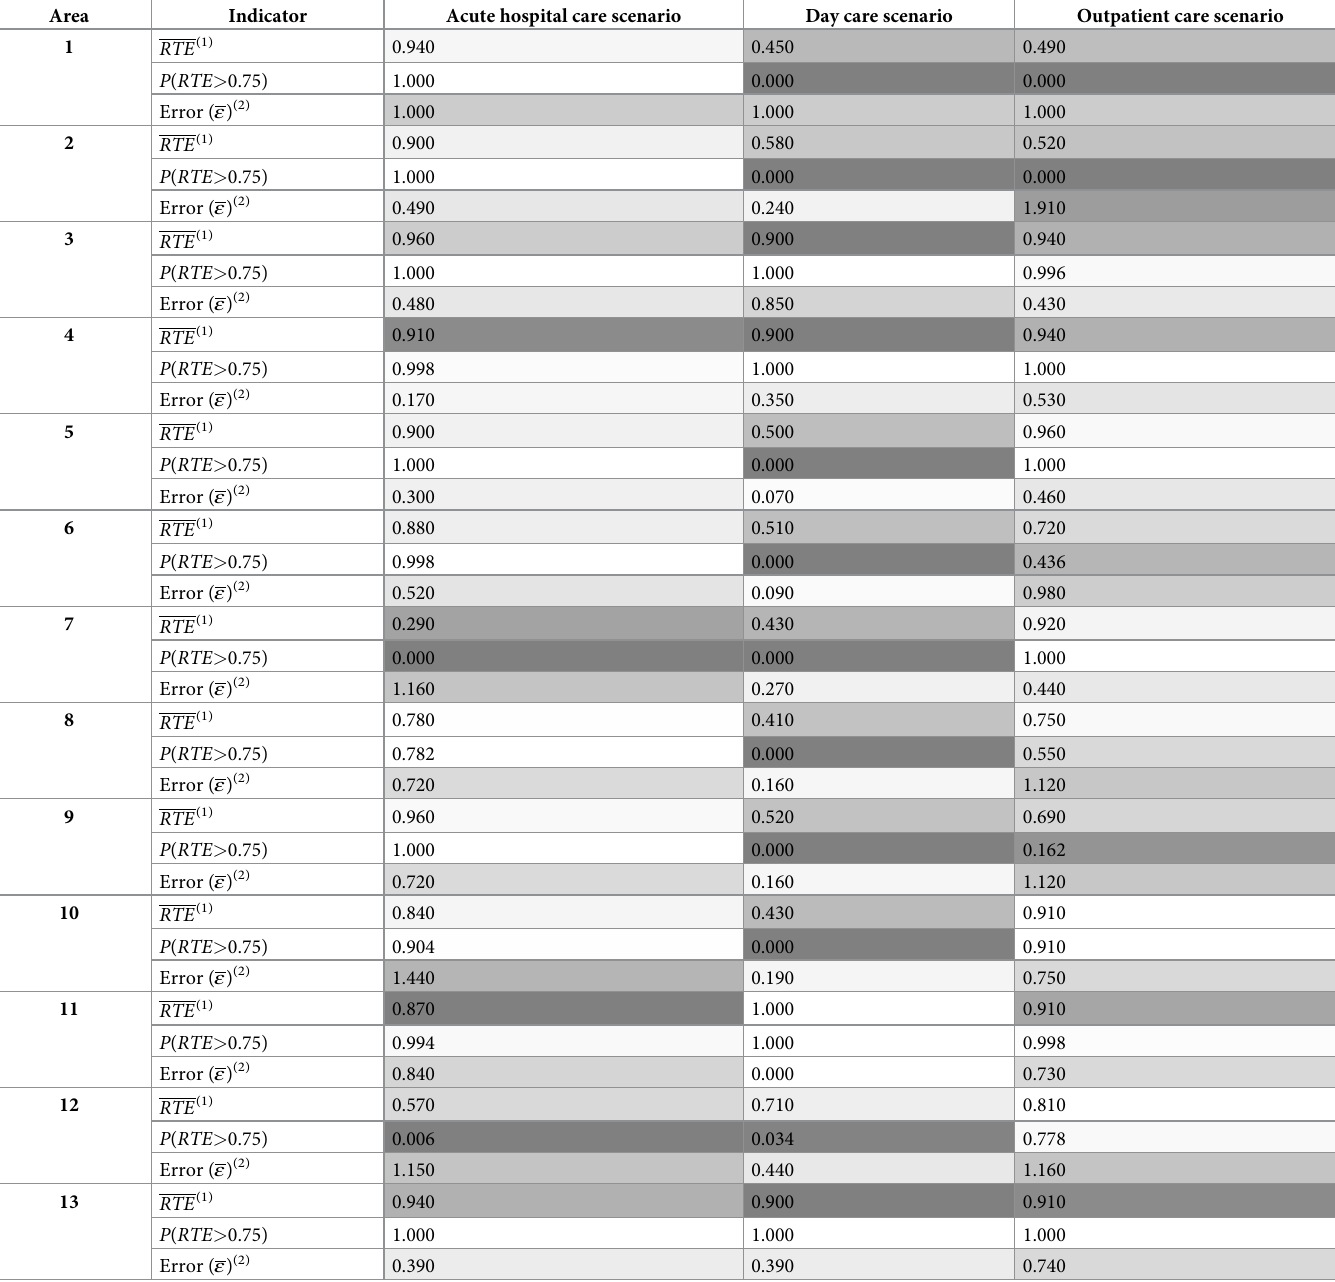
Table 3. Relative technical efficiency on average, RTE error on average and the probability of having an RTE greater than 0.75. Darker shading indicates worse scores.